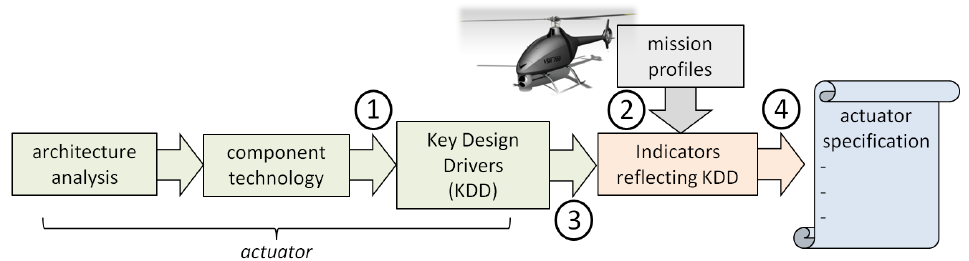
Figure 4. Proposed methodology for specification setup.